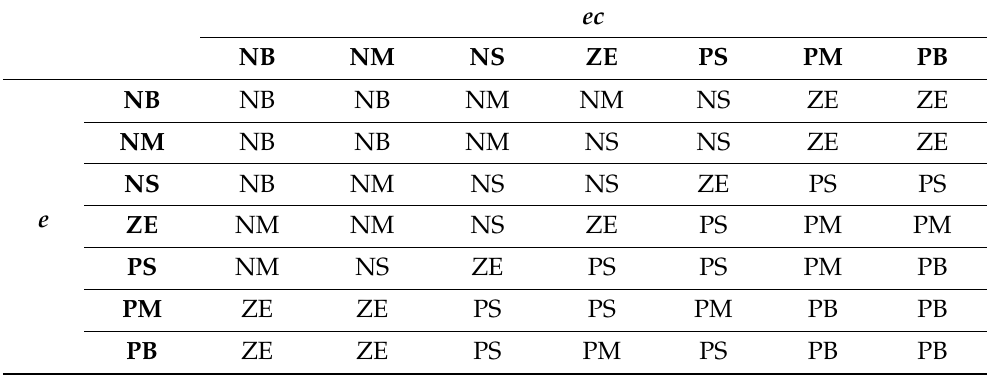
Table 2. Fuzzy Control Rule table of k i .